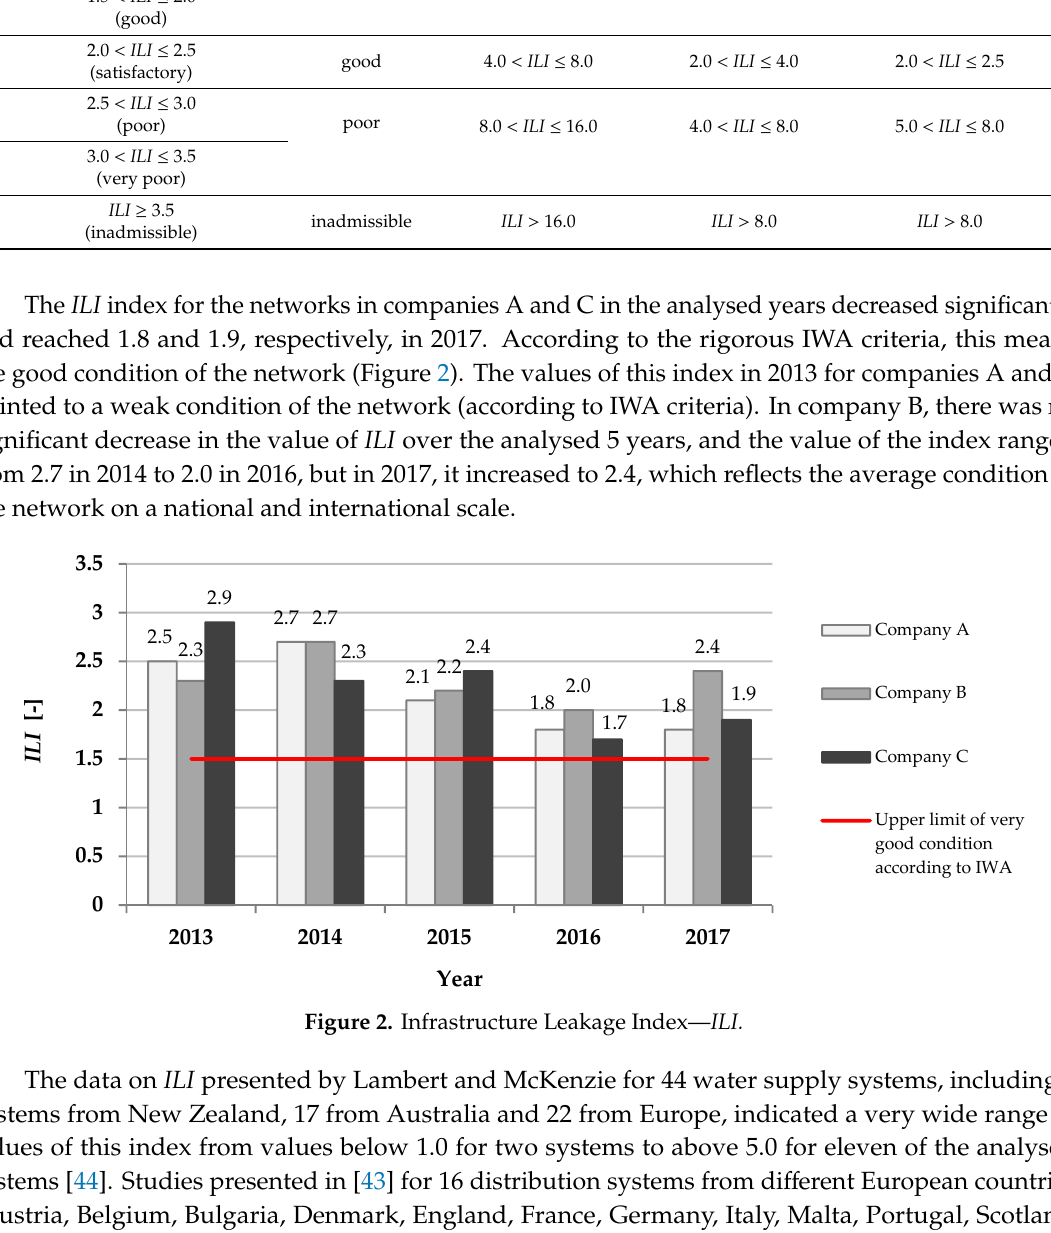
Table 7. Summary of indices of hydraulic load of a water supply system ( q 0 ) (m 3 /(km·day)). Company